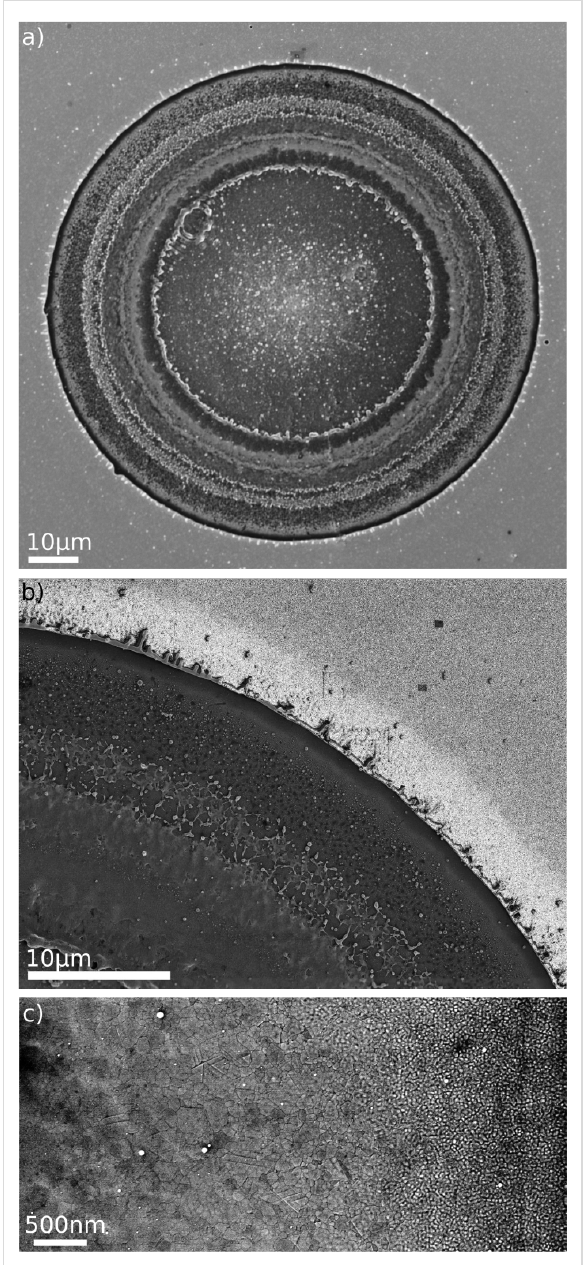
Figure 17: SEM micrographs of a 40 nm Au film on Si, after exposi- tion to a 300 ps laser pulse at 800 nm wavelength. (a) Overview over the ablation spot, (b) and (c) blow-ups of the transition region with two different magnifications.